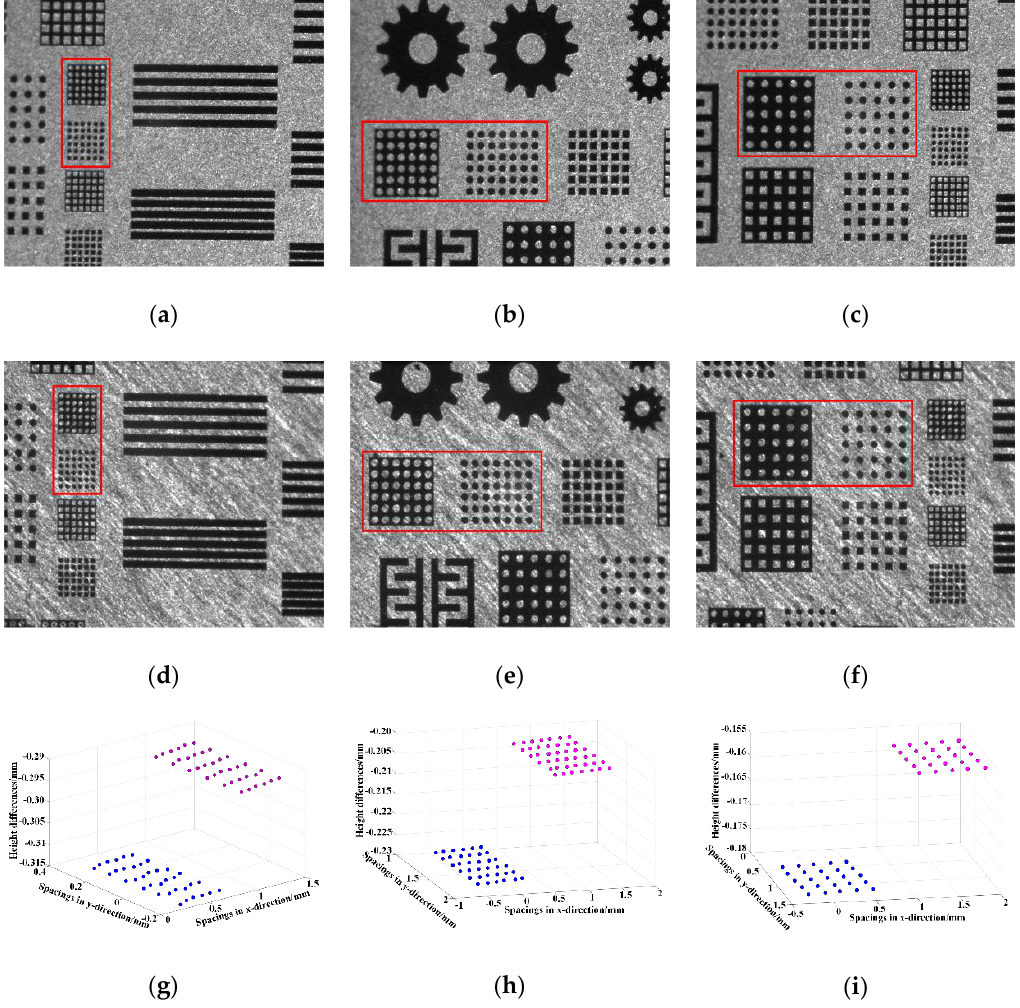
Figure 3. Three sets of cylinder arrays in red boxes contained in the images taken by the left and right cameras together with the corresponding reconstruction results. ( a ), ( b ), ( c ) were the left images, and ( d ), ( e ), ( f ) were the corresponding right images; ( g ), ( h ), ( i ) were the corresponding reconstructed height differences between the cylinders.